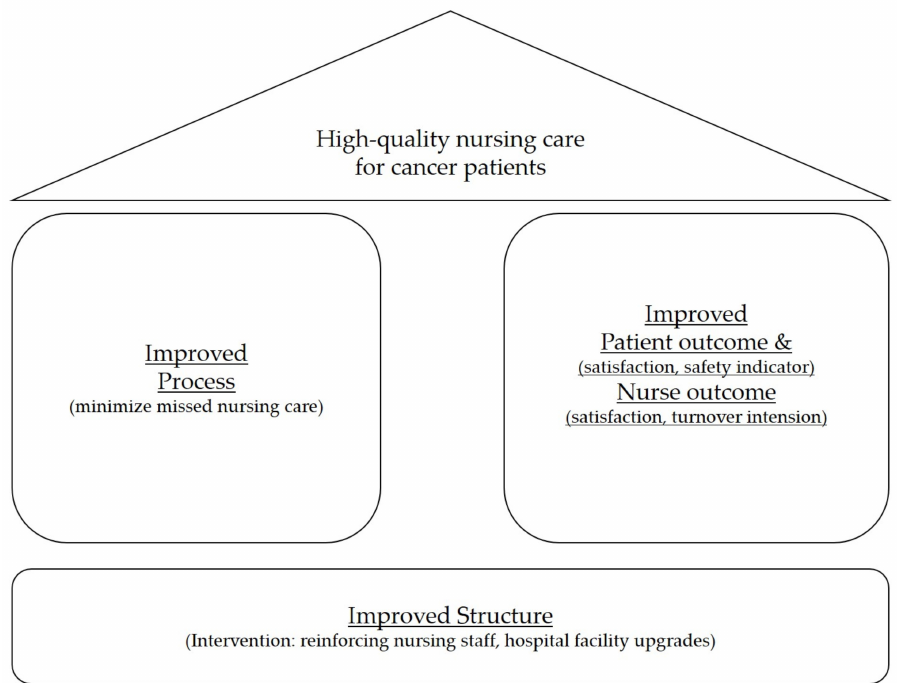
Figure 1. Conceptual framework of our